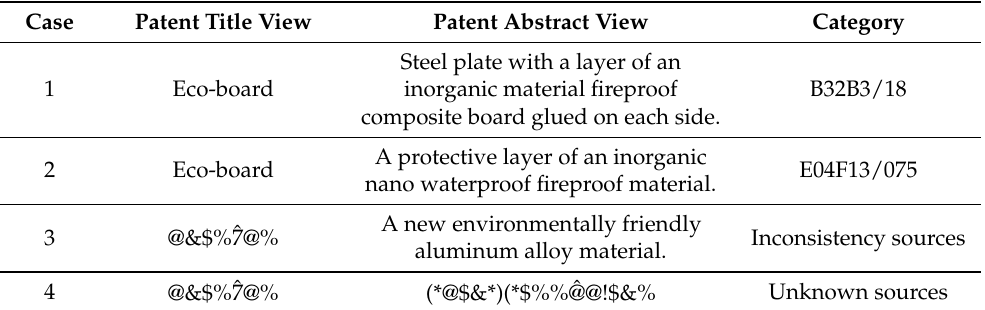
Table 1. The limitation of existing single-view-based patent classification methods and multi-view- based patent classification